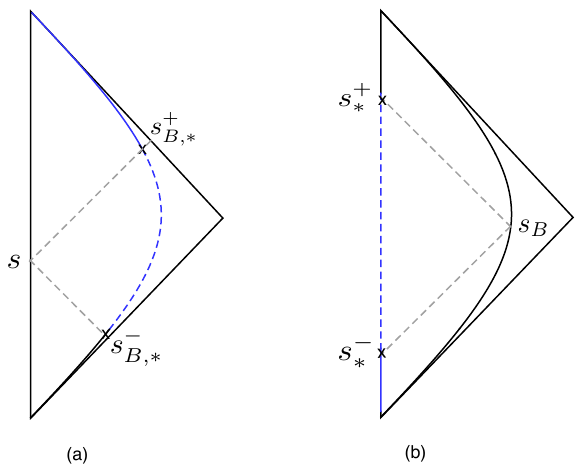
B integral is over the